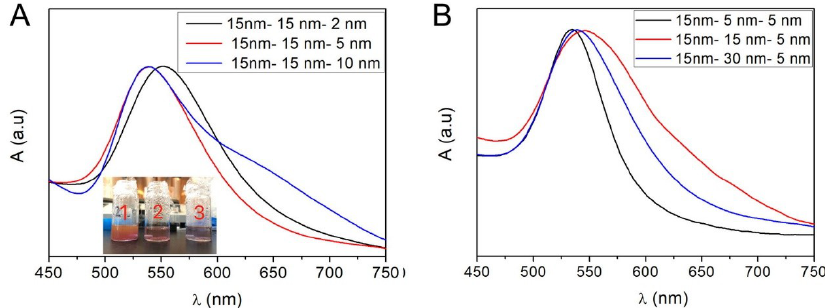
Figure 8. Experimental absorbance curves of UCNP@mSiO 2 -Au NPs ( A ) with different Au NPs added and ( B ) with different distance D between the UCNPs and Au NPs. The inset figure of Figure 8A shows the corresponding UCNP@mSiO 2 -Au solutions with enhanced Au NPs.